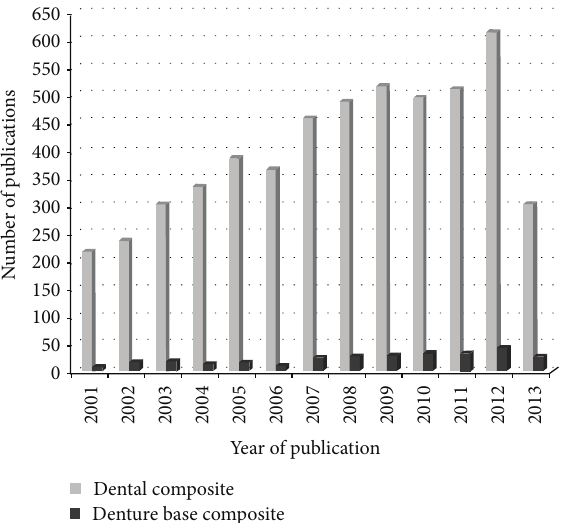
Figure 2: Increasing significance of dental composites compared with that of denture base composites. (Search keywords: dental composite and denture base composite in ISI Web of knowledge until October